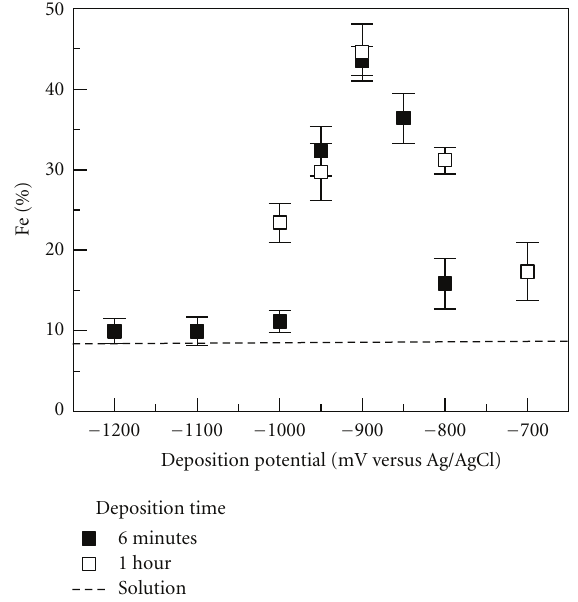
Figure 5: The iron content (percent by weight, Fe/(Ni + Fe) × 100%) in the electrodeposited films determined by PIXE as a func- tion of deposition potential for two di ff erent deposition times. The Fe content in the deposition solution (8.7%) is indicated by the dashed line.